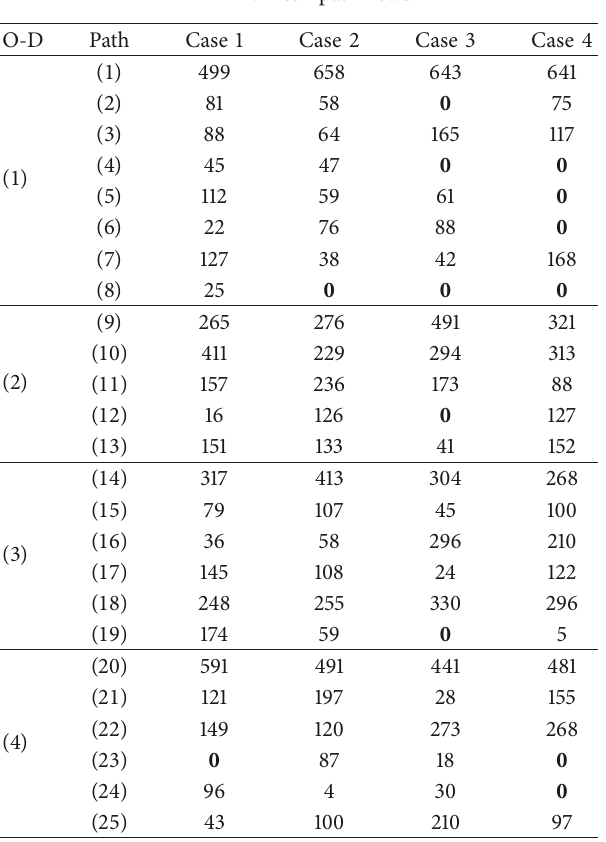
Table 4: Mean path flows.